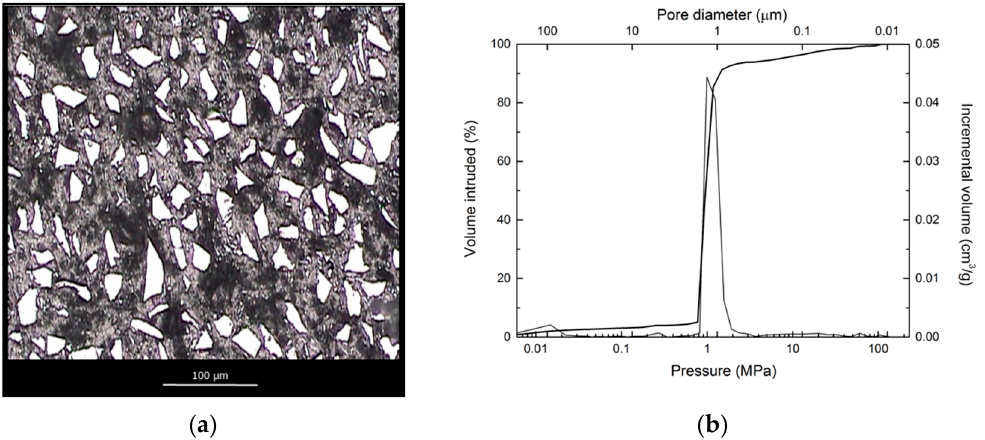
Figure 2. ( a ) Optical microscopy image of a polished cross-section of the SiC p /C preform; ( b ) mercury intrusion curve as a function of pressure and pore size distribution for the SiC p /C preform.